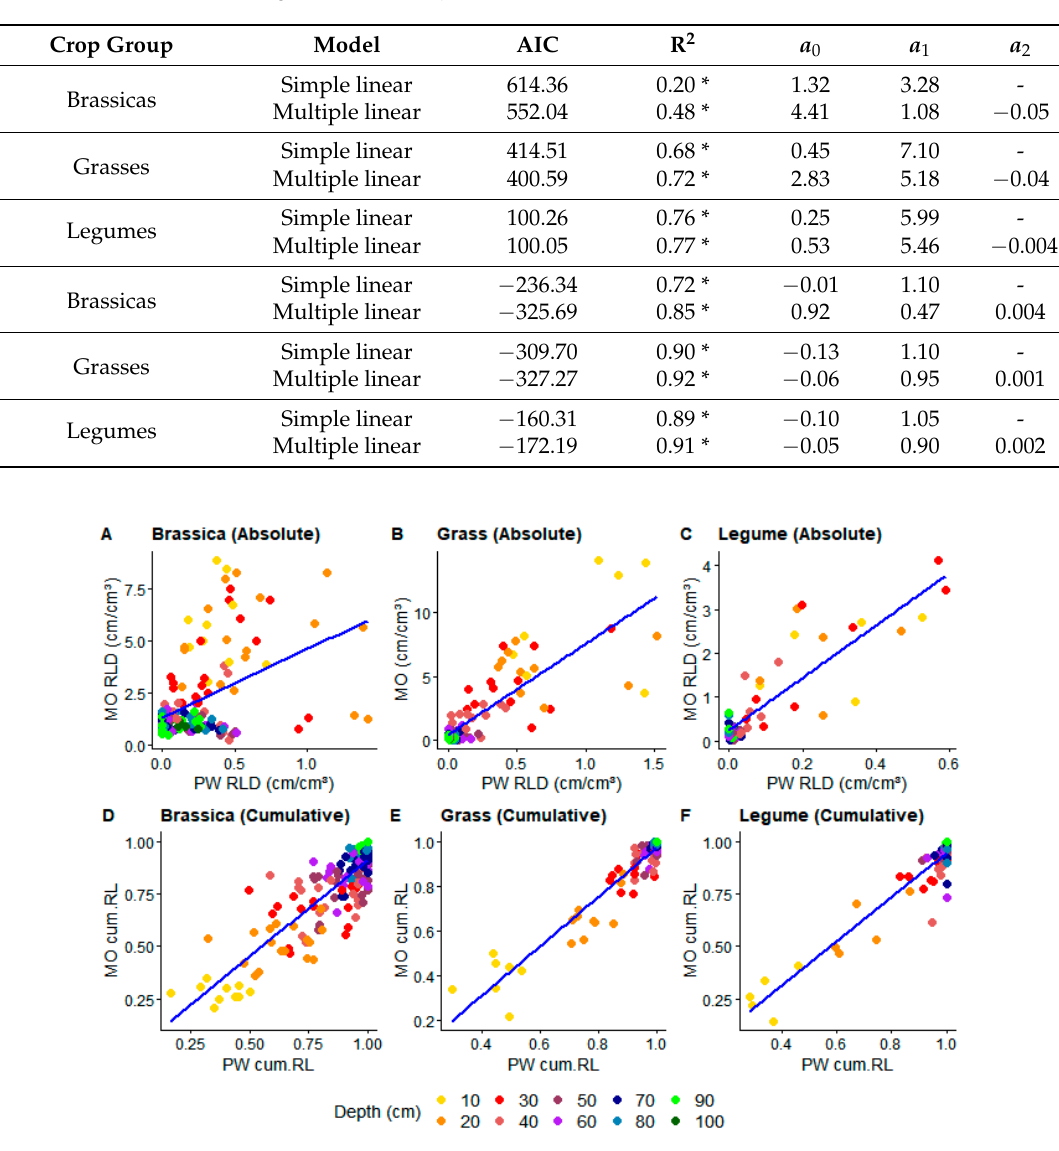
Table 3. Coefficients and quality metrics of linear regression models in training dataset, by crop group and data type. RLD, root-length density and cum. RL, cumulative root-length. Models are: simple linear model ( Y = a 0 + a 1 ( x )) and multiple linear model ( Y = a 0 + a 1 ( x ) + a 2 ( z ) ), where Y , monolith method RLD or cum. RL, x , profile wall RLD or cum. RL, z , soil depth (cm); a 0 , intercept; a 1 , coefficient to multiply by x and a 2 , coefficient to multiply by z . AIC. Akaike’s information criterion for model comparison. R 2 , coefficient of determination and * indicates that the correlation between PW and MO was significant, with a p -value < 0.05.